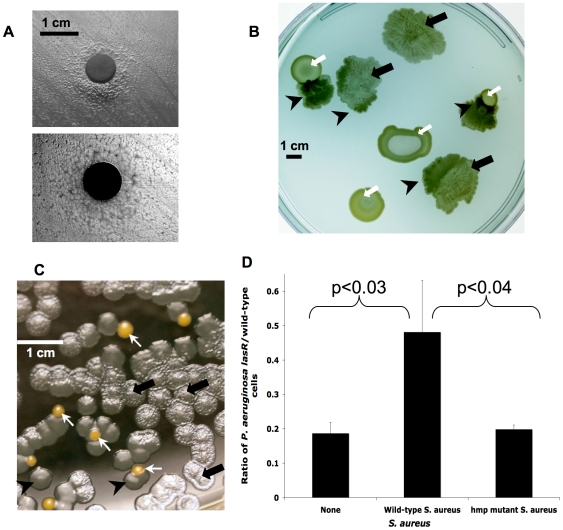

lasR mutant P. aeruginosa growth is altered during co-culture with S. aureus, apparently due to detoxification of NO·.(A) Cells in a lawn of lasR mutant PA14 growing near a disk containing hemoglobin, which stoichiometrically scavenges NO· (as opposed to the catalytic effect of S. aureus colonies in B–C), do not display the autolysis of cells more distant from the disk, as shown in a photograph from above with illumination from above (upper) and below (lower). (B) Clinical isolates of lasR mutant P. aeruginosa (black arrows) and S. aureus (white arrows) grown together on LB agar with 400 µM added KNO3, with lasR colony autolysis and resulting translucency indicated through transillumination of the agar plate. Black arrows indicate areas of P. aeruginosa lysis and/or sheen, white arrows indicate colonies of S. aureus, and black arrowheads indicate where lasR colony autolysis is relieved in the presence of S. aureus. (C) Co-culture as in (B) except with laboratory strain PA14-lasR::Gm grown with wild-type S. aureus Newman strain (colored orange in silico for clarity) after inoculation at a cell ratio of 50∶1. Arrows as in (B). (D) Ratios of cell counts of P. aeruginosa lasR versus wild-type after inoculation of static cultures in liquid LB with 400 µM added KNO3 with equal numbers of each P. aeruginosa strain followed by growth for 48 hours in the presence and absence of equal cell numbers of the indicated S. aureus strains. Results are averages ±s.d. for triplicate counts and are representative of three separate experiments. Total final cell count was similar in each experiment.